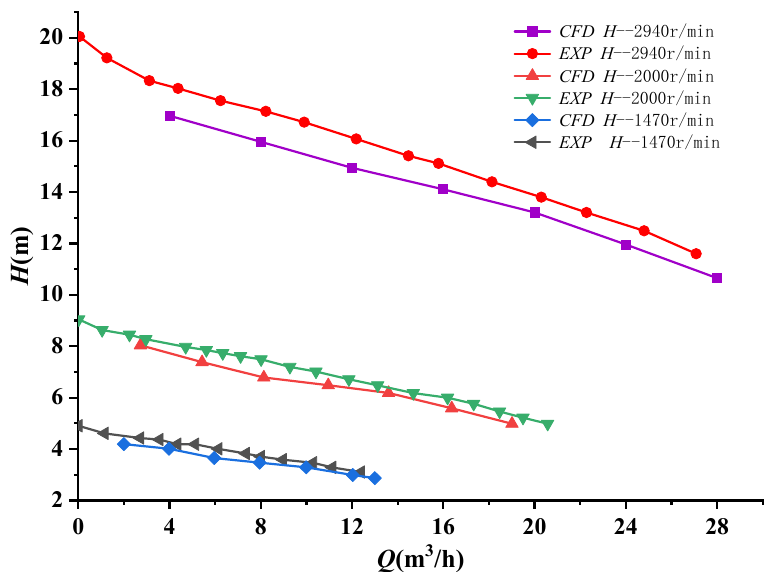
Figure 5. H-Q Curve Comparison.